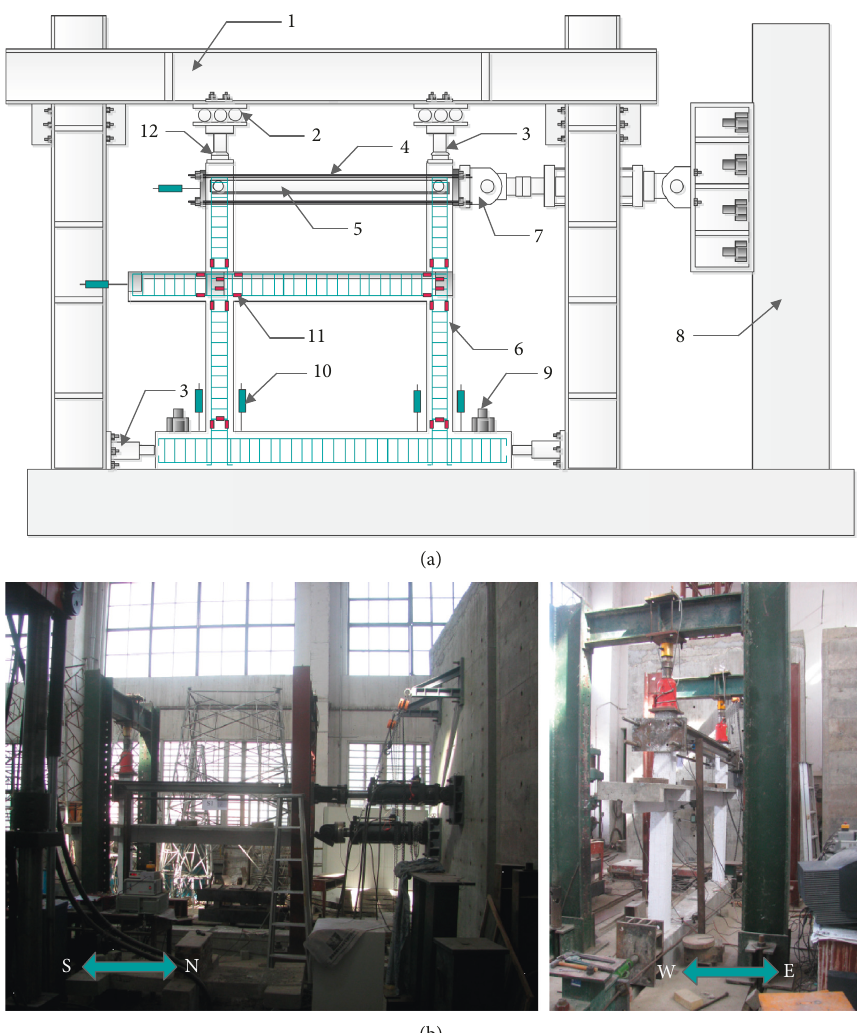
Figure 3: Experimental setup: (a) schematic diagram of test arrangement; (b) test field photographs. Note: 1, counterforce frame; 2, sliding vehicle; 3, jack; 4, steel tension rod; 5, angle steel coupling beam; 6, frame specimen; 7, electrohydraulic servoactuator; 8, reaction wall; 9, anchor bolt; 10, LVDT; 11, strain gauge; 12, load cell.